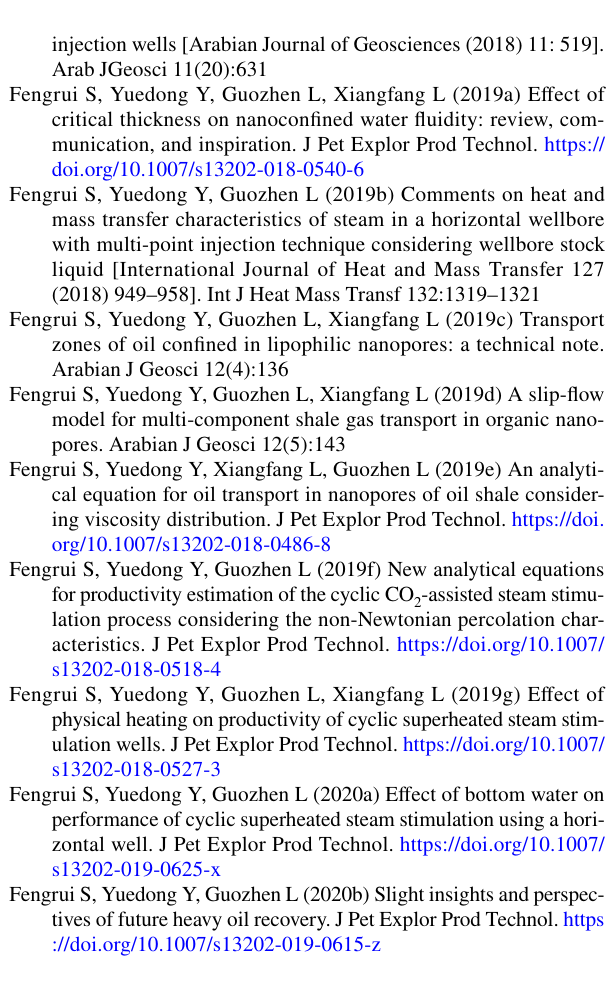
Fig. 6 The temperature fields under various permeability distribution